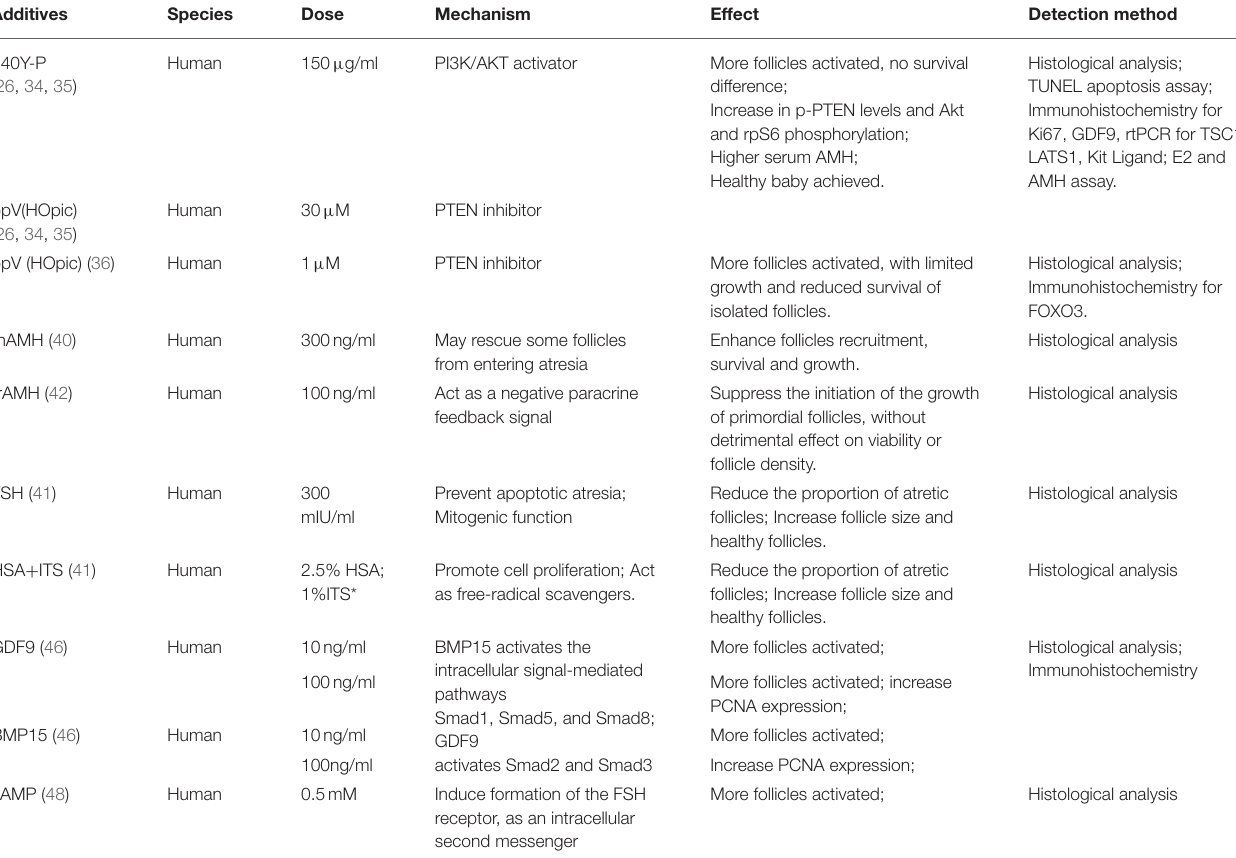
TABLE 1 | Reported additives in human follicle in vitro activation stage. Additives